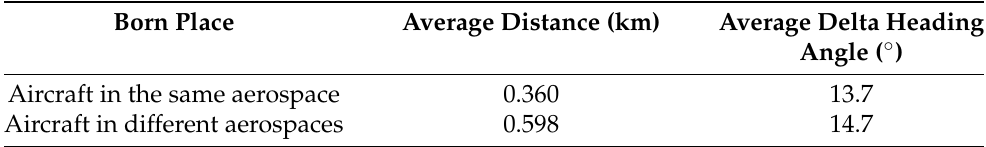
Figure 15. Trajectories of aircraft trained in team aircraft guidance: ( a ) three aircraft starting in the same aerospace, flying to the aimed for 4D waypoints, respectively, and ( b ) three aircraft starting in different aerospaces, flying to the aimed for 4D waypoints, respectively. Table 6. Average distance and delta heading angle to